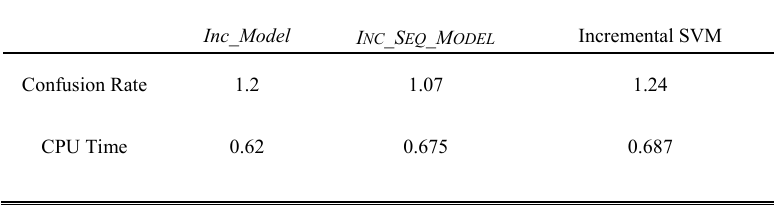
Table 4. Normalized Confusion Rates and CPU Requirements with respect